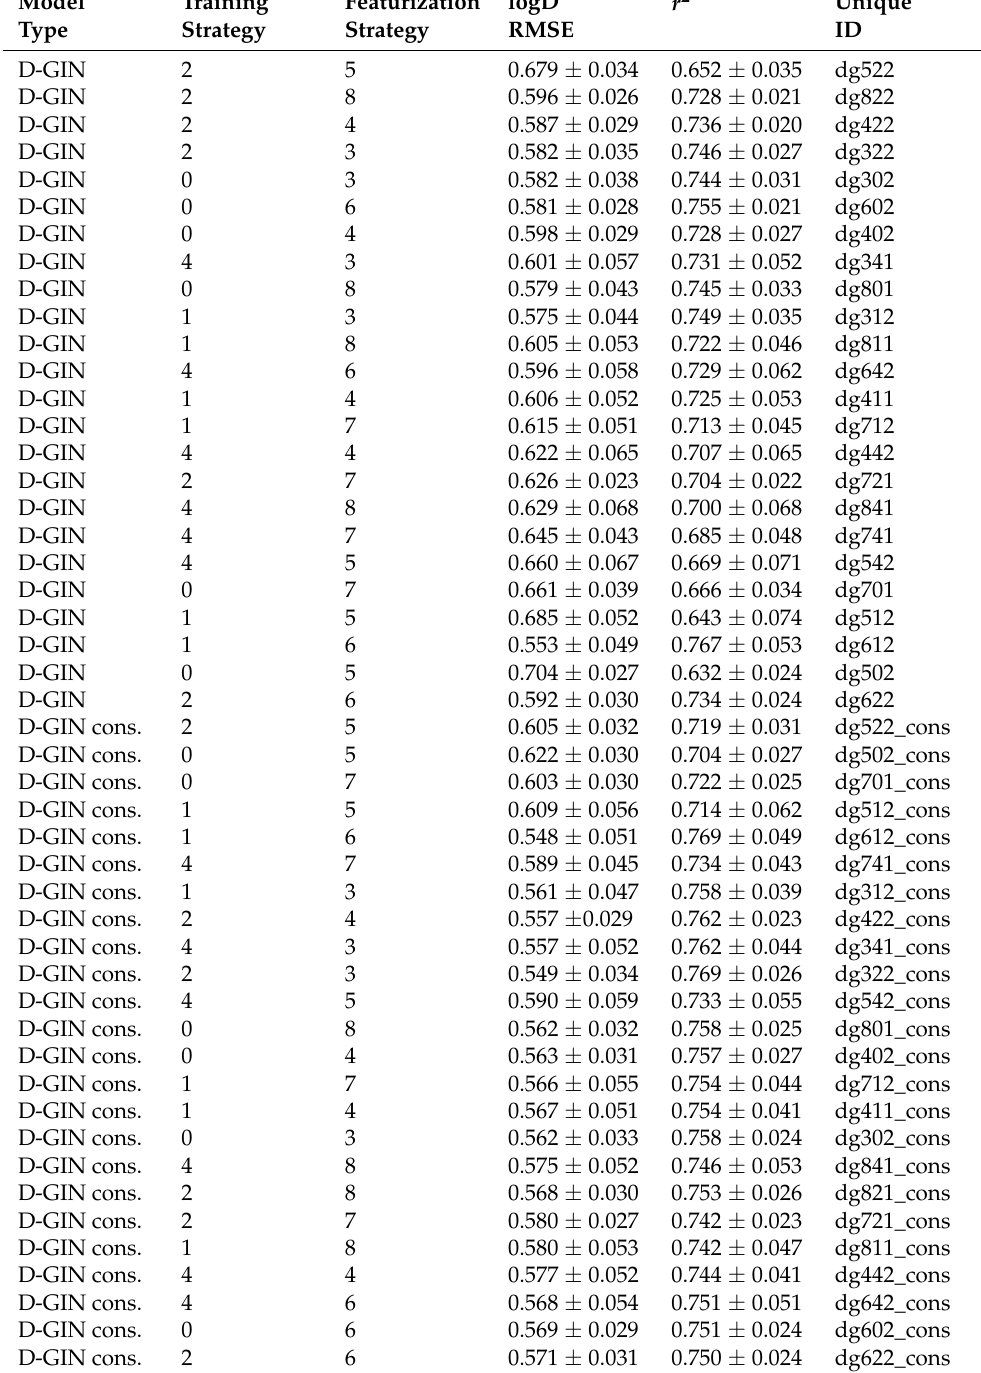
Table A8. Shows the log D RMSE and r 2 results for the D-GIN model type used during this survey. The last column consist of the unique identify. Training strategy 0 represents a training strategy combining logD, logS, and logP, 1 represents a strategy combining logD and logP, 2 stands for a combination of logD and logS, 3 represents a strategy using logS and logP, 4 represents a strategy using logD, 5 represents a strategy using logS, and 6 represents a strategy using